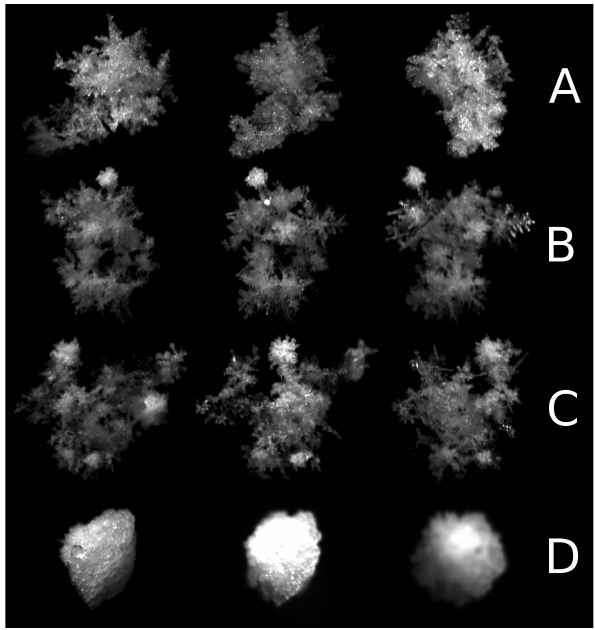
Fig. 5. Triplet stereoscopic images of individual snowflakes imaged with the MASC. The center resolution is 9µm and outside image resolution is